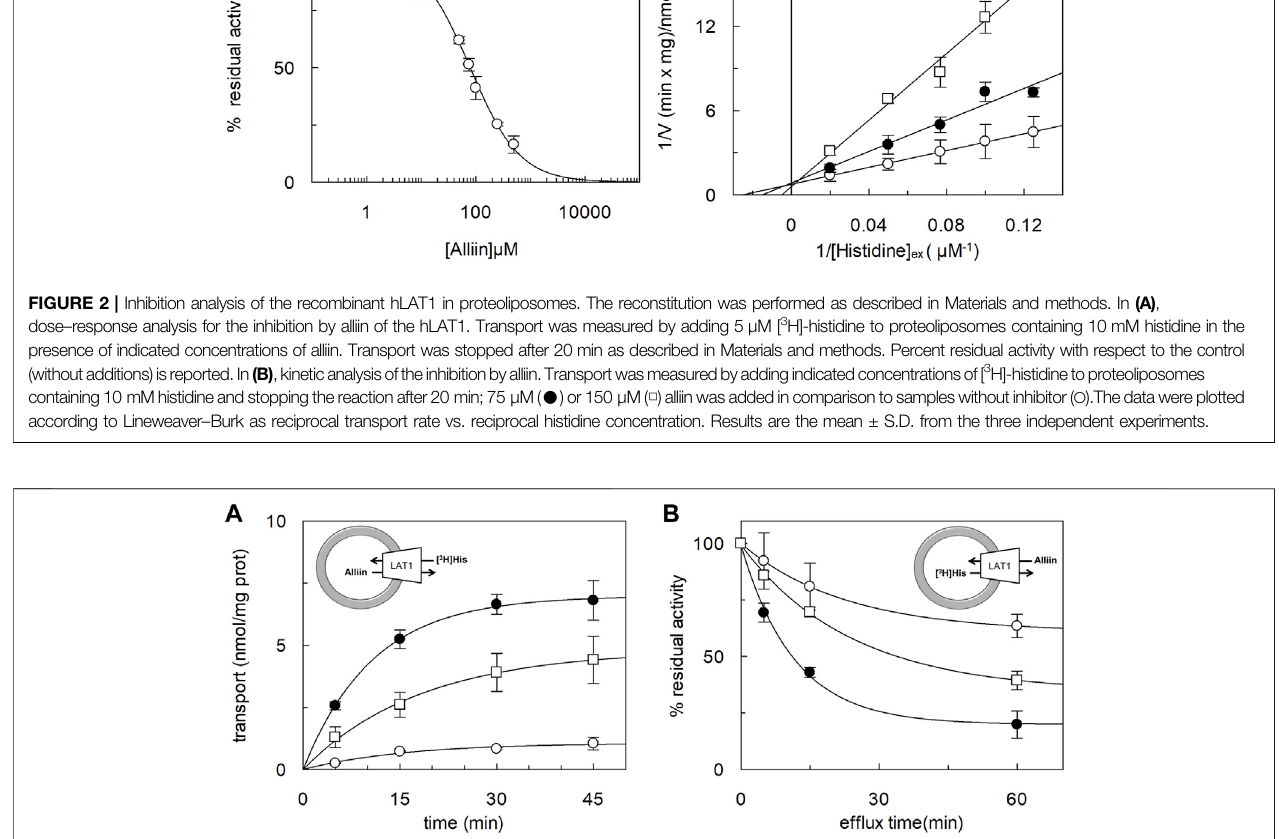
FIGURE3| Timecourseofhistidineuptakeandef fl uxinproteoliposomes.Thereconstitutionwasperformedasdescribed inMaterialsandmethods. (A) Transport was started by adding 5 μ M [ 3 H]-histidine to proteoliposomes containing 1 mM histidine ( C ), or 1 mM alliin ( □ ), or without the internal substrate ( ○ ). The transport reaction was stopped at the indicated times according to the stop inhibitor method as described in Materials and Methods. (B) Uptake of 5 μ M [ 3 H]-histidine was performed in 60 min. Then, the ef fl ux of [ 3 H]-histidine was measured in the absence of the external substrate ( ○ ), or in the presence of 0.1 mM of external histidine ( C ) or alliin 0.1 mM ( □ ) at the indicated times. The data are calculated as the percent of residual activity with respect to the control sample (ef fl ux time zero). Results are the mean ± SD of three independent experiments. The experimental model is depicted as a sketch.